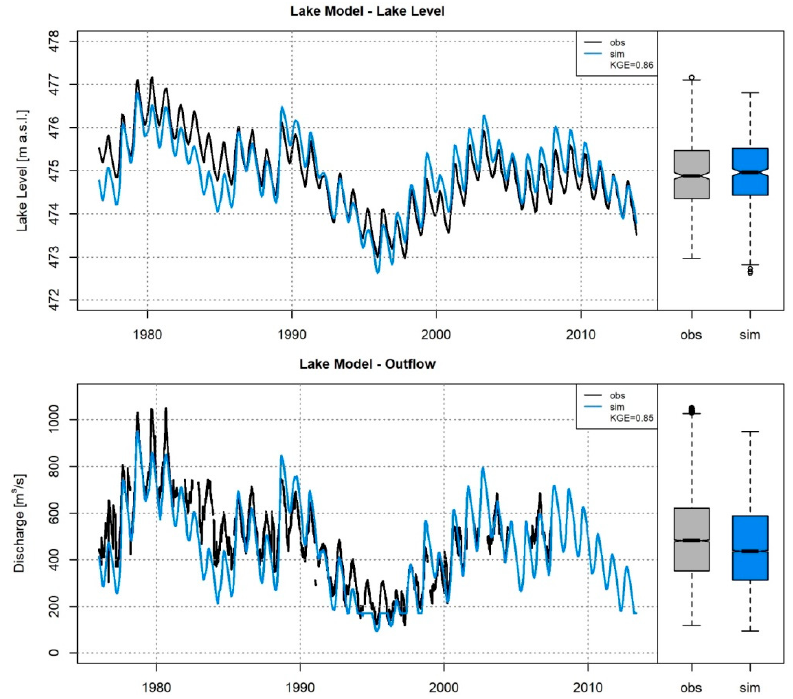
Figure 5. Simulated time series and boxplots for lake level ( upper ) and lake outflow ( bottom ), as simulated by the Lake Malawi Model (LMM) for the period 1976–2013 against observations.